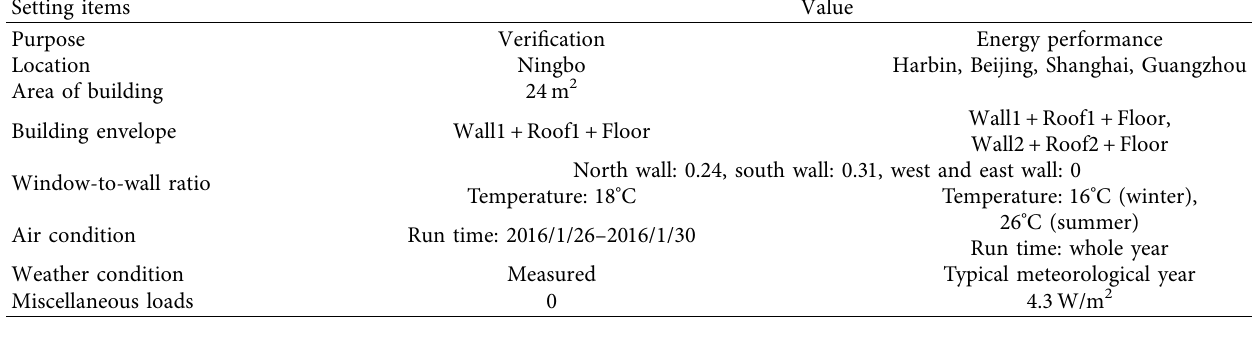
Table 2: Setting items of building models.